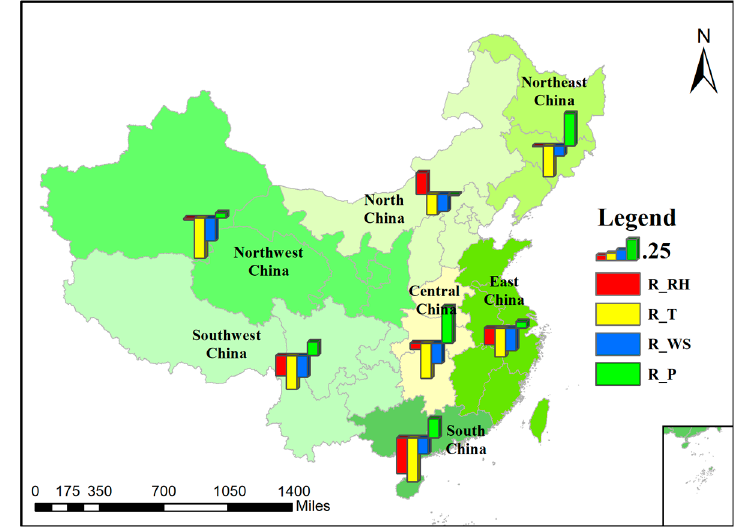
Figure 8. Histograms of the correlation coefficient (r) values in the seven regions.